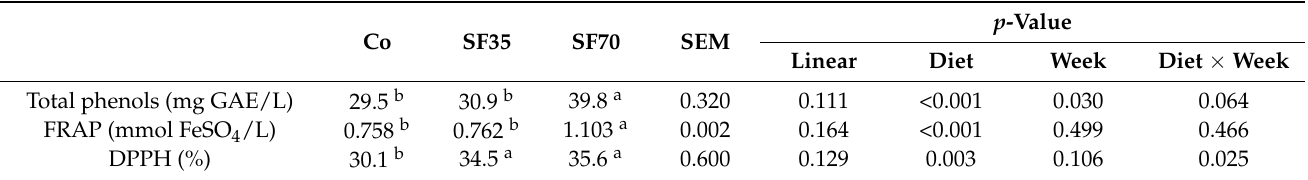
Table 6. Least square means and standard error of the mean of total phenols and antioxidant activities of goat milk according to diet ( n = 80 for each group). p -Value Co SF35 SF70 SEM Linear Diet Week Diet ×